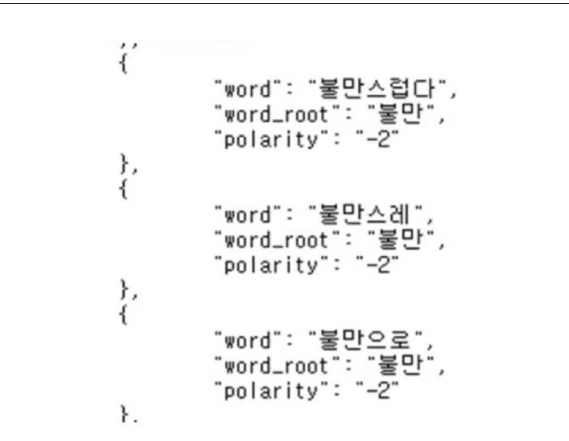
FIGURE8 Korean emotional dictionary.